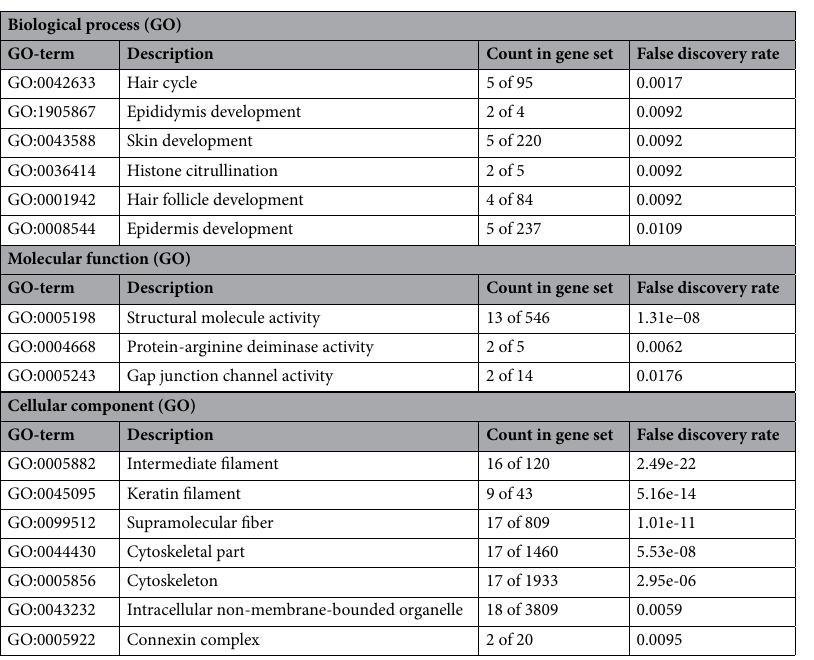
Table 5. GO-Terms Enrichment of putative Gm44393 linked